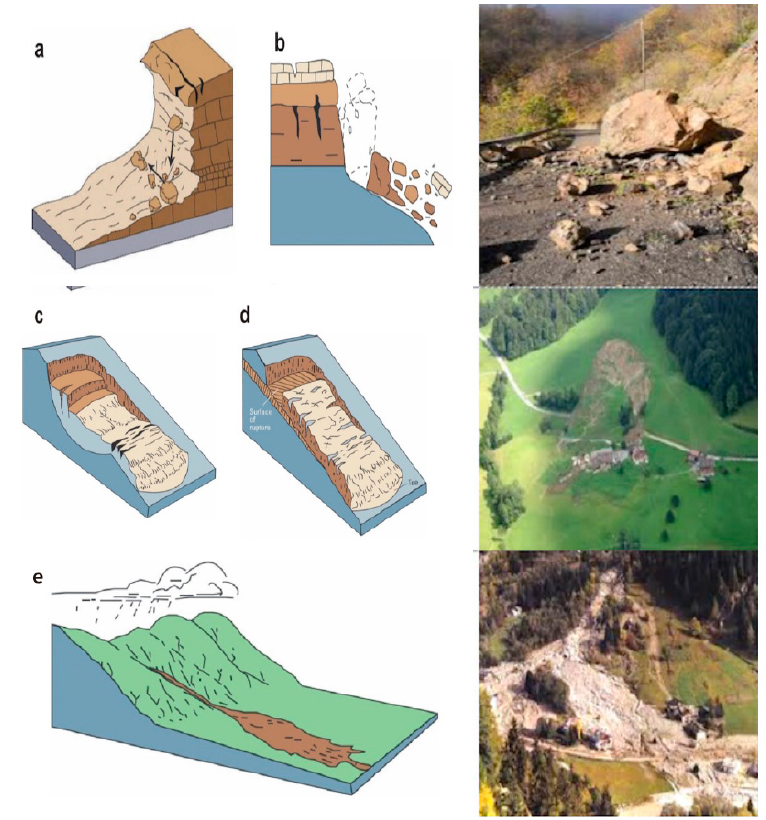
Figure 1. Varnes’ classification with examples, from a textbook.